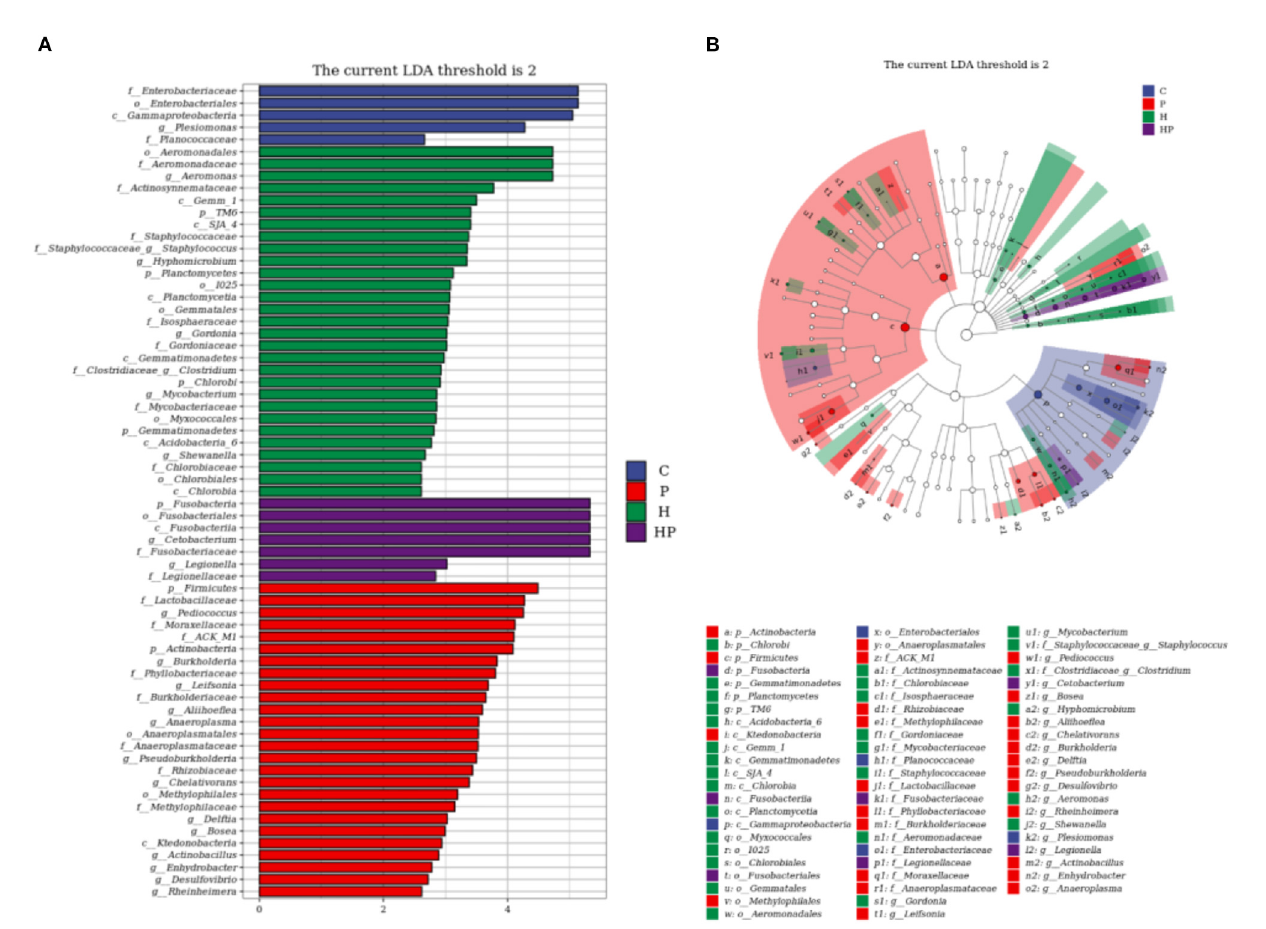
FIGURE5 LEfSe analysis explored the discriminative microbiota in group C, P, H, and HP, respectively. (A) The LDA score histogram; (B) the cladogram. p < 0.05 was used as a threshold for LEfSe analysis.